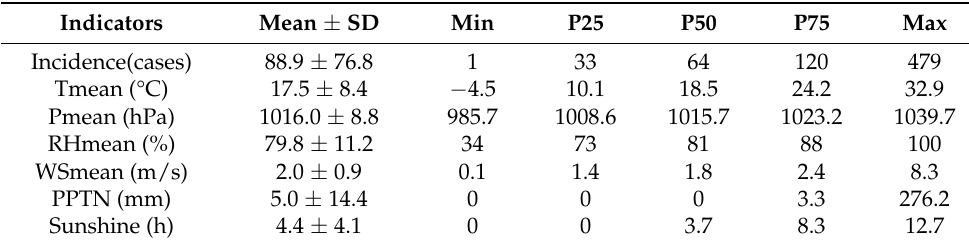
Table 1. Descriptive statistics of daily incidence of HFMD cases and meteorological factors in Ningbo,